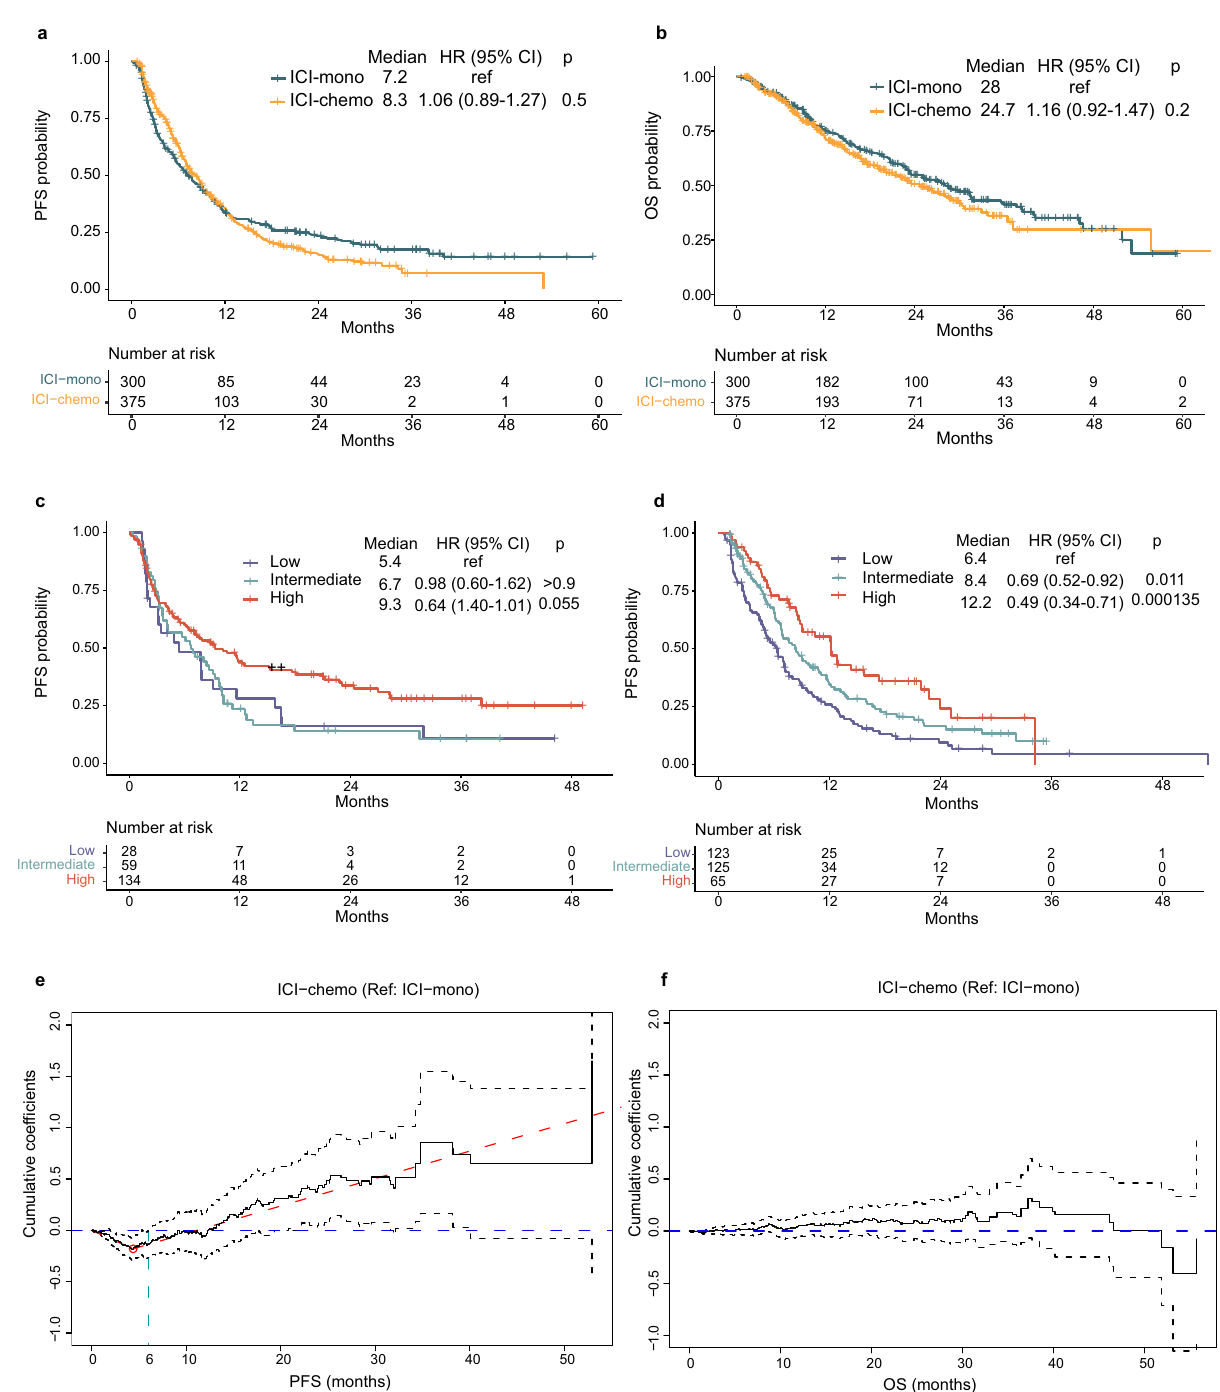
Fig.1| Clinicaloutcomesin fi rst-linepatientstreatedwithimmunecheckpoint inhibitors(ICI)asmonotherapy(ICI-mono, n =300)orwithchemotherapy(ICI- chemo, n =375) in the MDACC primary cohort. Comparison of a , progression- free survival (PFS) and b , overall survival (OS) between ICI-mono vs ICI-chemo. c ,PFSinICI-monostrati fi edbyPD-L1. d PFSinICI-chemostrati fi edbyPD-L1.Hazard